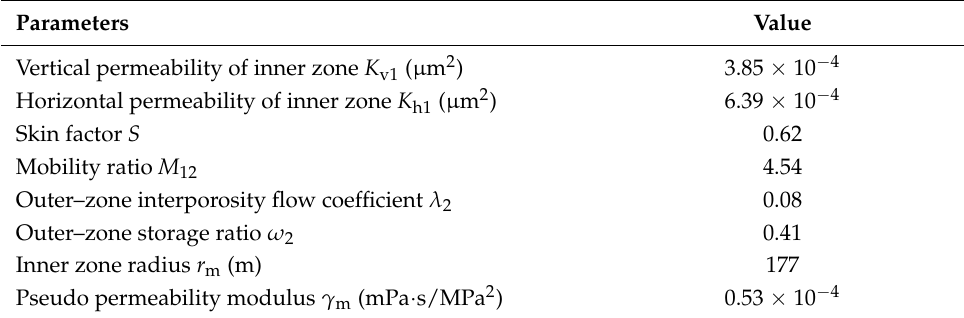
Table 3. The pressure transient analysis results of the X1